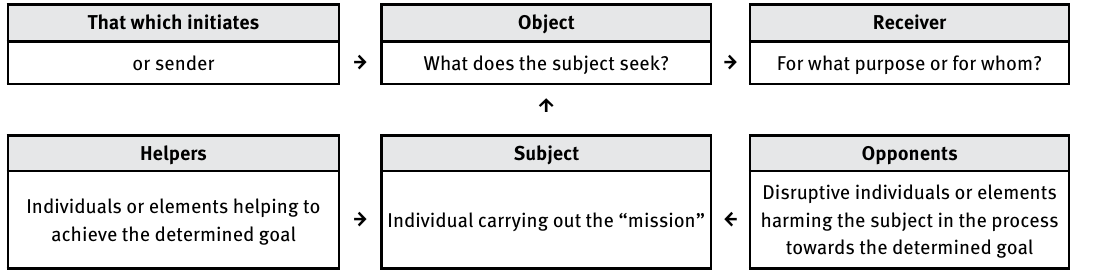
Figure 2 . Actantial model adapted for our